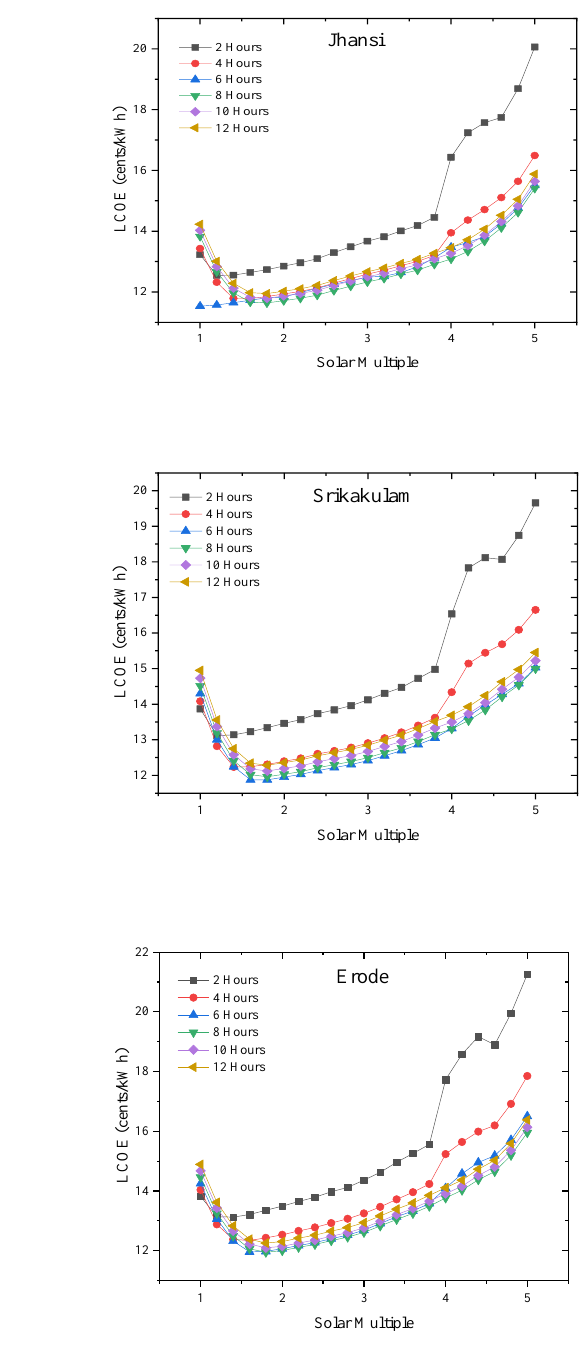
Figure 8. Effect of SM and TES on the LCOE (wet-cooled model) for potential sites in India.